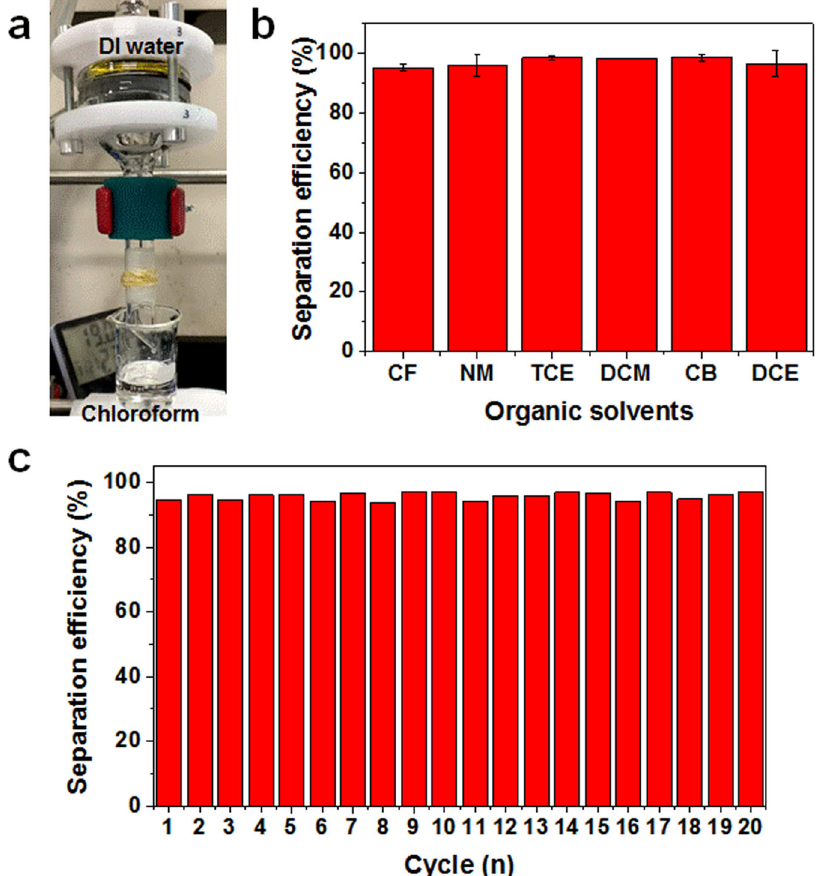
Fig. 5 Oil/water separation performance of F-PU in-and-out coated ACF. a Photograph images of the oil/water separation system containing the F-PU in-and-out coated ACF. b Separation ef fi ciencies of the F-PU in-and-out coated ACF for CF/water, nitromethane (NM)/ water, Trichloroethylene (TCE)/water, dichloromethane (DCM)/water, chlorobenzene (CB)/water, and 1,2-dichloroethane (DCE)/water mixtures. c Separation ef fi ciencies of F-PU in-and-out coated ACF for CF/water mixture as a function of the number of oil/water separation cycles. The error bars represent the standard deviations of the